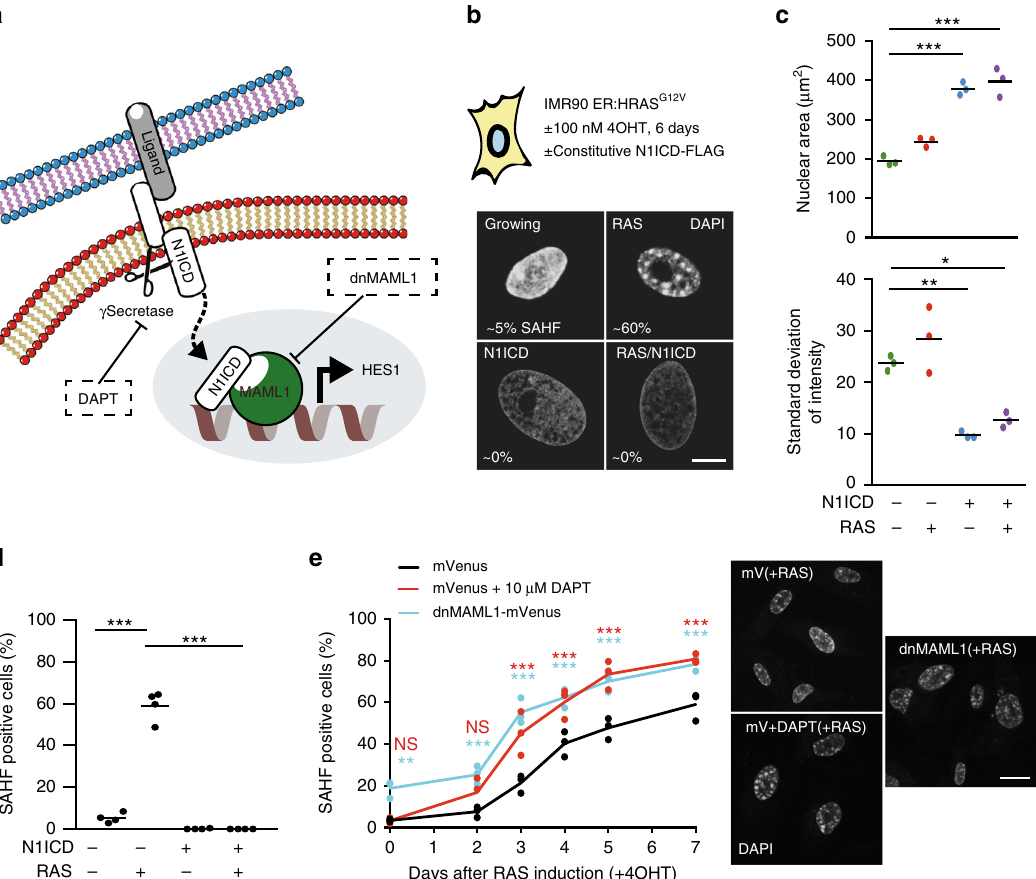
Fig. 1 NOTCH1 signalling has a chromatin ‘ smoothening ’ effect that blocks SAHF. a Diagram illustrating the NOTCH1 signalling pathway, which can be repressed chemically using DAPT or genetically by expressing dominant-negative MAML1 (dnMAML1). b IMR90 ER:HRAS G12V cells were infected with control vector or N1ICD-FLAG and incubated with ±100 nM 4OHT for 6 days. Representative images of nuclei stained with DAPI for the conditions indicated (scale bar = 10 µ m). Percentage indicates the number of SAHF-positive cells within the population (see d ). c , d Quanti fi cation of nuclear area, standard deviation of DAPI intensity ( c ) and the number of SAHF-positive cells ( d ) for the conditions indicated in b . Lines indicate the mean value of each replicate. n = 3 ( c ) and n = 4 ( d ) biologically independent replicates. Values of individual replicates for nuclear area and standard deviation are shown in Supplementary Fig. 1b, d. e Time series analysis of SAHF-positive nuclei following the addition of 100 nM 4OHT to IMR90 ER:HRAS G12V cells in the presence or absence of ectopic dnMAML1 or 10 µ M DAPT (left). n = 3 biologically independent replicates. Representative DAPI images of the indicated conditions ( + RAS = 7 days of 4OHT treatment; scale bar = 25 µ m). c – e Statistical signi fi cance calculated using one-way ANOVA with Tukey ’ s correction for multiple comparisons. * p ≤ 0.05, ** p ≤ 0.01, *** p ≤